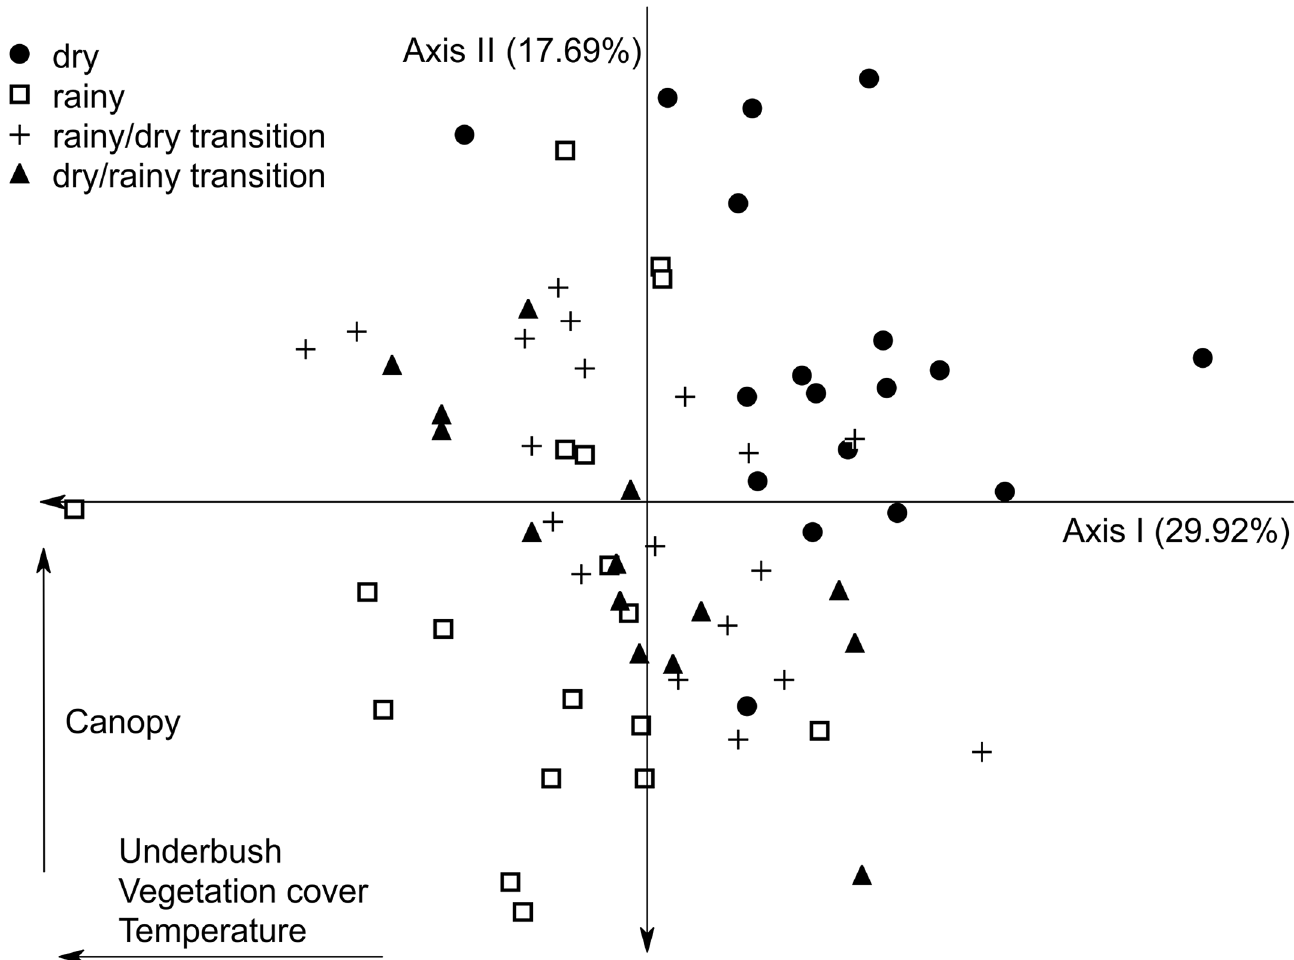
Fig 4. Principal Component Analysis (PCA) ordination for the environmental variables selected in the first and second axis (first axis: Underbush, vegetation cover, temperature and second axis: canopy). Dry season are representedby circles, Rainy by squares, Rainy/dry transition by plus and Dry/rainy transition by triangles. Numbers in parenthesesare the percentageof variance explained by each axis.